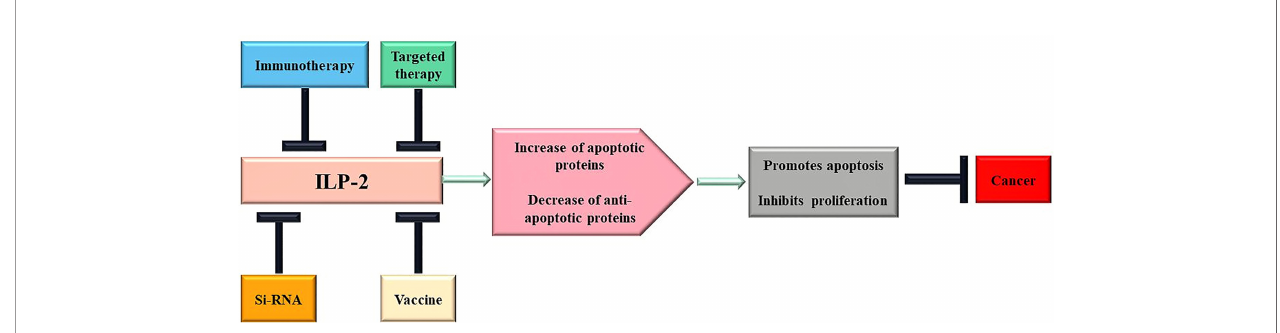
FIGURE 5 | Scheme of therapeutic approaches potentially triggered by ILP-2. Multiple changes of apoptotic proteins contribute to cancer development and progression, and treatment targeting ILP-2 can be developed to restore normal sensitivity to apoptotic stimuli and, therefore, repress